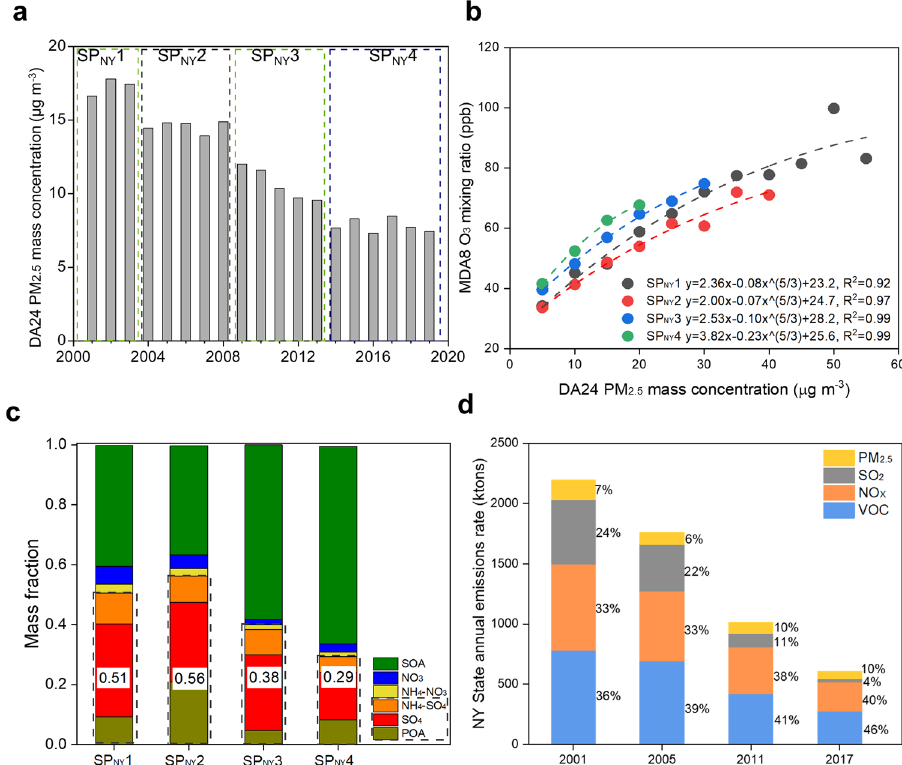
Fig. 1 O 3 and PM 2.5 in NYC. a The time series of the annual summertime average DA24 PM 2.5 in NYC for each subperiod speci fi ed in the main text; b NYC O 3 -PM 2.5 relationship for the different subperiods with the non-linear fi tting; c the aerosol mass fraction for each subperiod in NYC based on the AMS measurement from the representative year (Black dash box indicates SAP compounds. The number in each column indicates the SAP mass fraction); d the VOC, NO x , SO 2 , and primary PM 2.5 emissions of NY state in 2001, 2005, 2011,